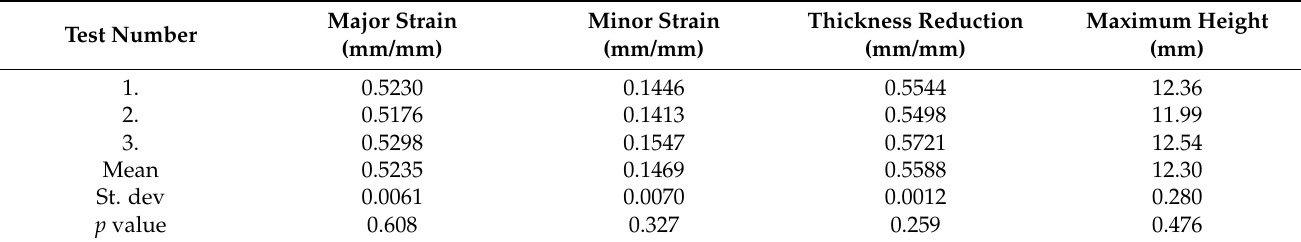
Table 12. Results of the uniaxial tool path test for double side welded